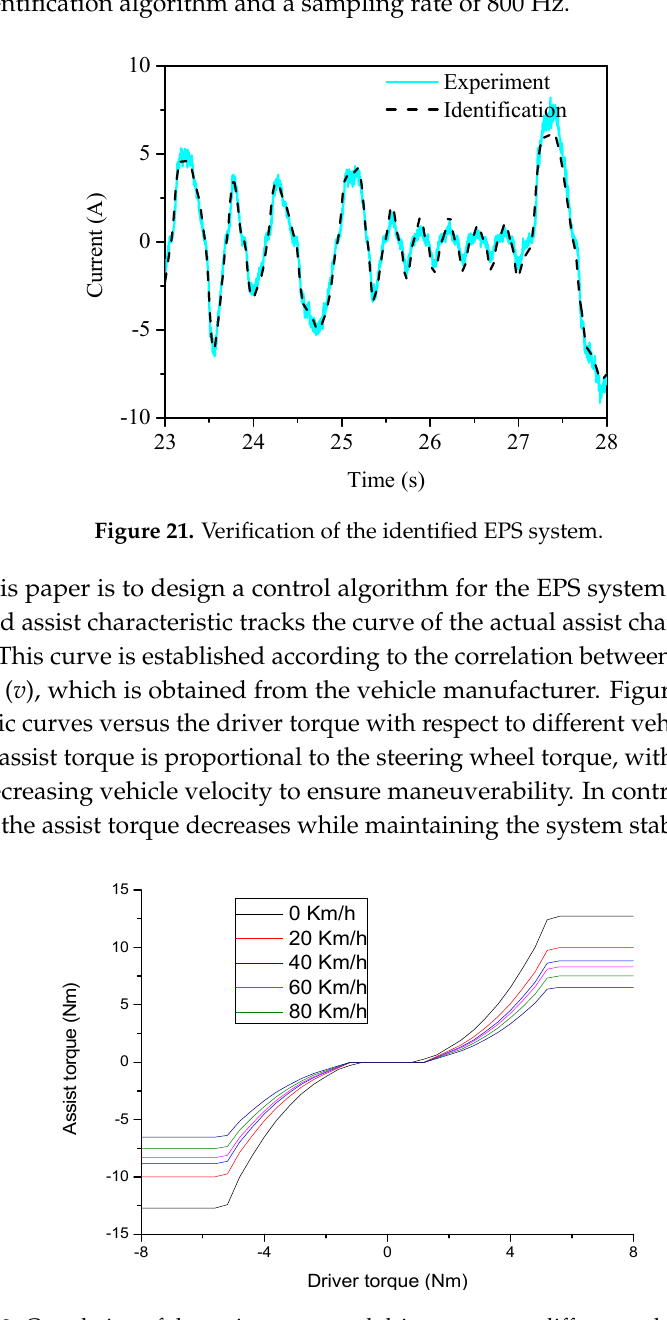
Figure 22. Correlation of the assist torque and driver torque at different vehicle speeds.